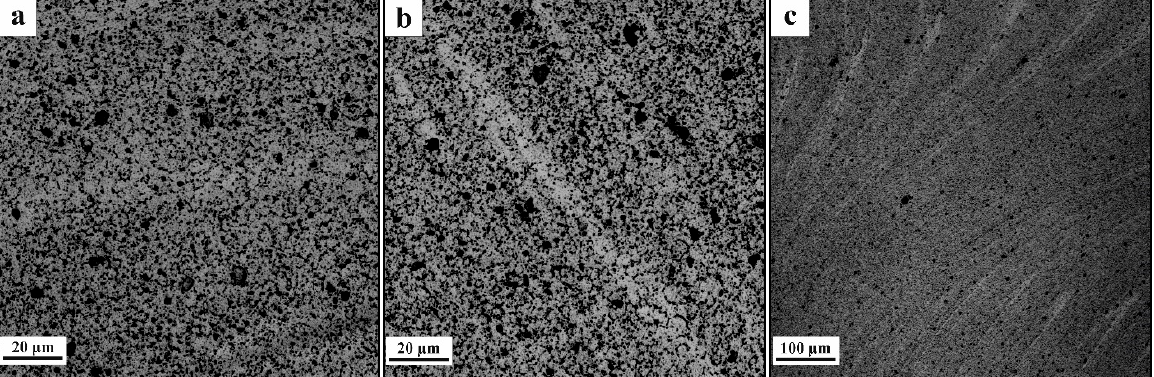
Figure 8. Microstructure of FSP-ed RPPs/AA5056 composite after 8 passes: ( a ) stir zone; ( b ) thermo- mechanically affected zone; ( c ) zone accumulations of RPs.